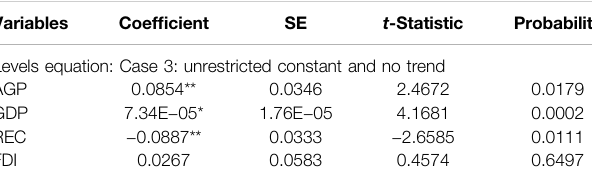
TABLE 6 | Estimated long run coef fi cients based on Akaike information criterion